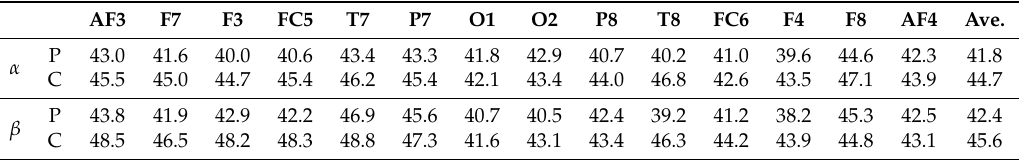
Table 1. Equal error rate (EER, %) when presenting personal ultrasounds.